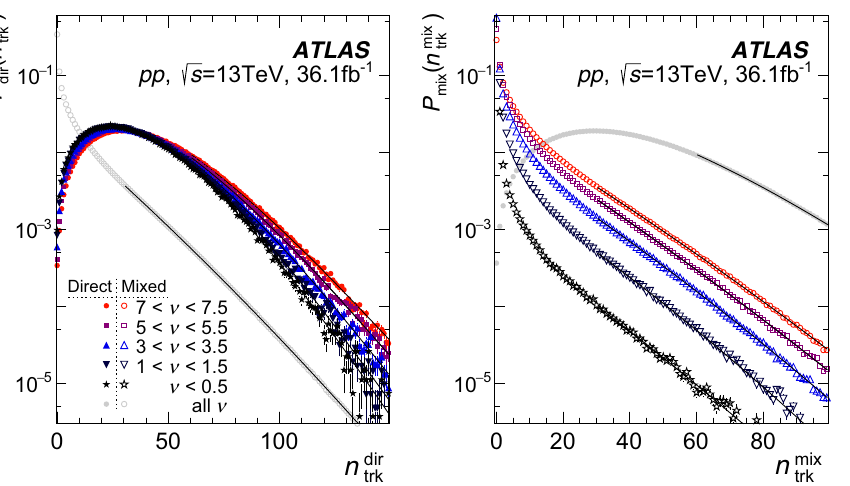
Fig. 5 Probability distributions for the n trk in Direct events (left) and Mixed events (right). The different coloured markers correspond to dif- ferent values of ν . The grey distribution in each panel indicates the dis-